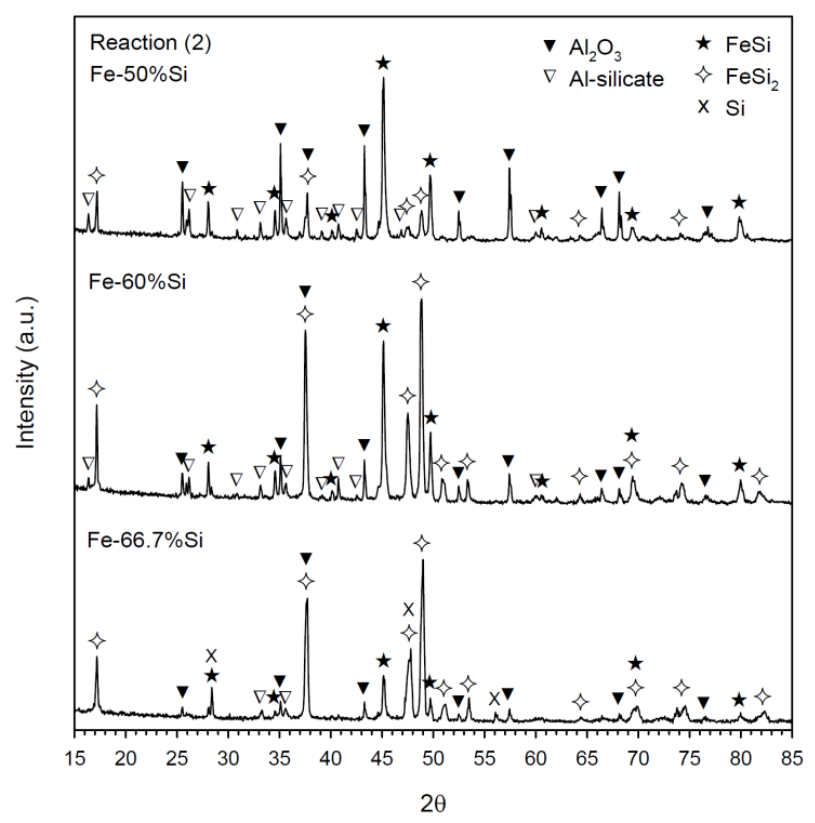
Figure 5. XRD patterns of SHS products of Reaction (2) with Si percentages of Fe-50% Si, Fe-60% Si, and Fe-66.7% Si.